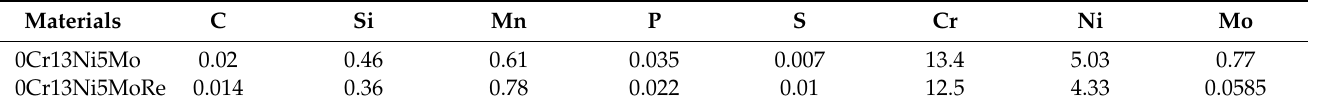
Figure 1. CAD schematic of the hydraulic turbine runner structure. Table 1. Compositions of 0Cr13Ni5Mo steel and 0Cr13Ni5MoRe (mass fraction,